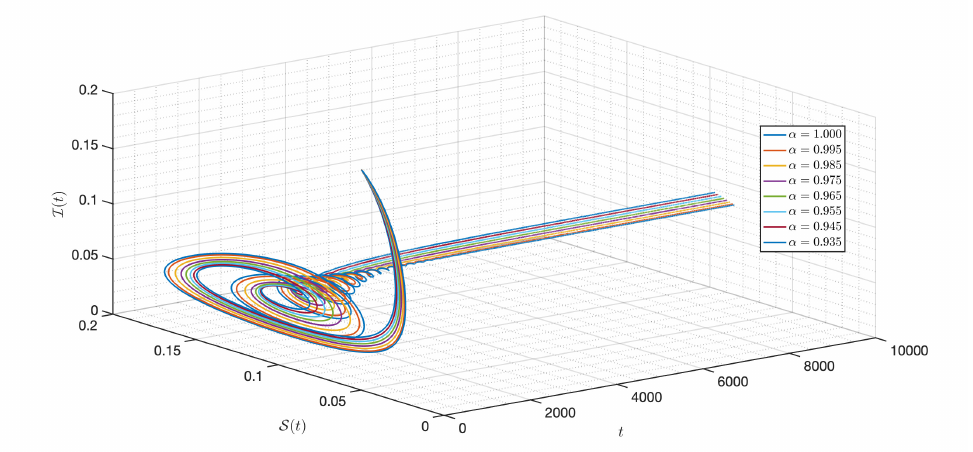
Figure 42. Dynamic of the model (3) for different parameters in Case IV